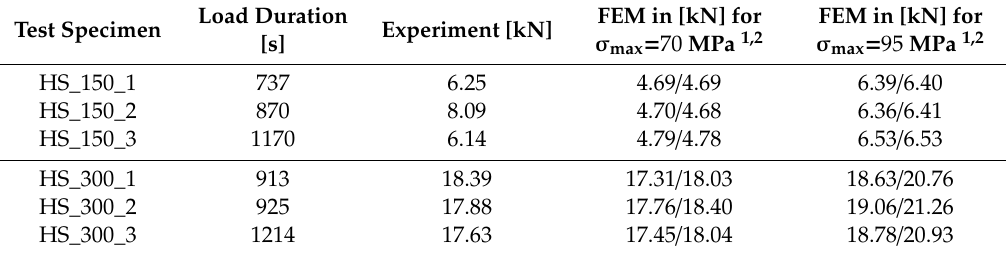
Table 6. Comparison of ultimate loads from experiments and numerical simulations for HS-glass.